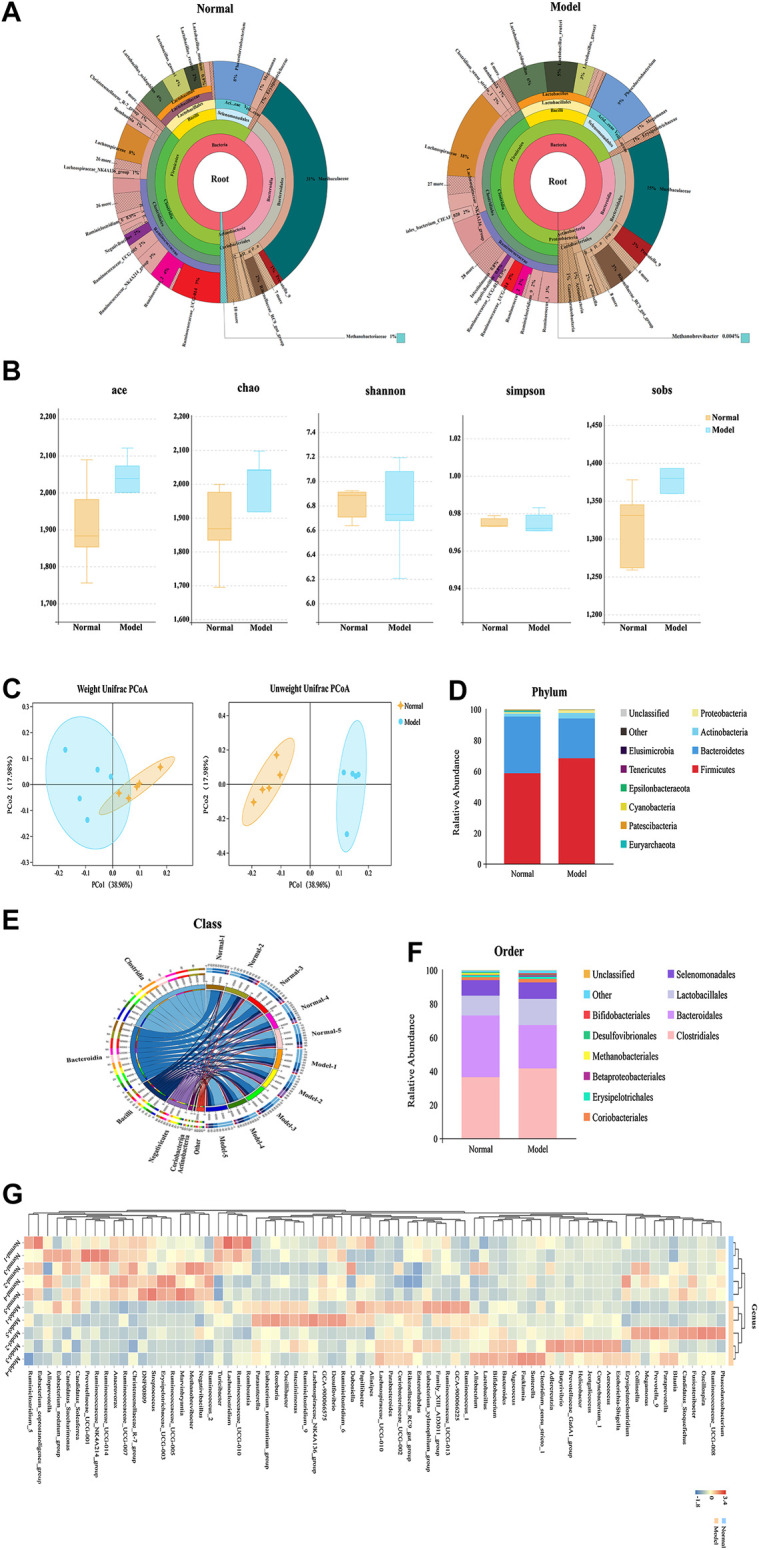
Comparative analysis of fecal microbial diversity and composition in IgAN rats. (A) Cladogram of differentially abundant taxa between normal and model. (B) The alpha-diversity indices (Ace, Chao1, Shannon, Simpson, and Sobs) of the normal and IgAN model groups were calculated based on OTU levels. (C) Principal coordinate plot showing the beta diversity between the normal and model rats, based on unweighted and weight ed UniFrac analyses. p value indicates differential clustering, as evaluated using the ADONIS test. (D) Component proportion of microbiota between the normal and model groups from fecal 16S rDNA sequencing data at the phylum level (top 10). (E) Stacking diagram of species distribution between normal and model groups at the order level (top 10), as revealed using 16S rDNA sequencing. (F) Circos showing the microbial composition of each sample from the normal and model groups at the class level (top 10). (G) Heatmap displaying the microbial composition of each sample from the normal and model groups at the genus level.